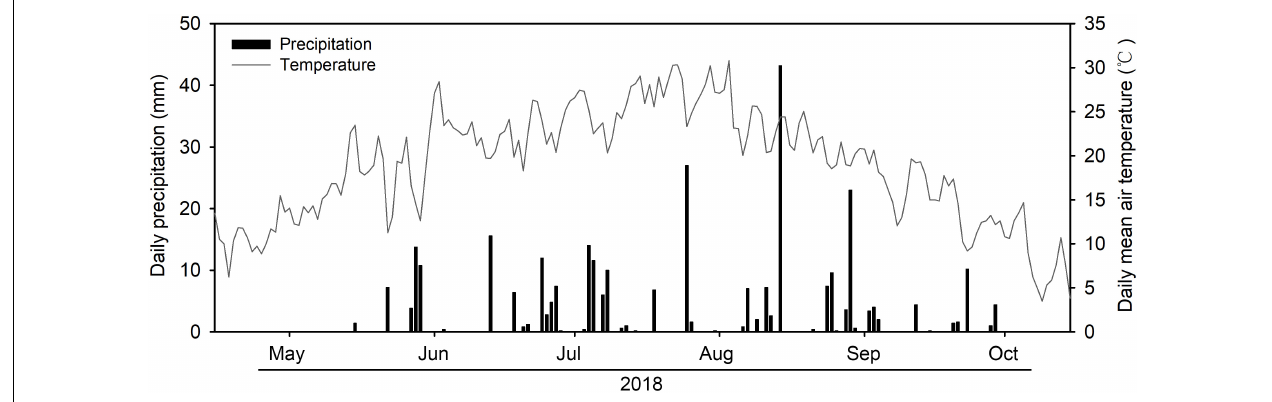
FIGURE 1 | Daily precipitation (bars, mm) and daily mean air temperature (lines, ◦ C) of growing season (May to October) in 2018.